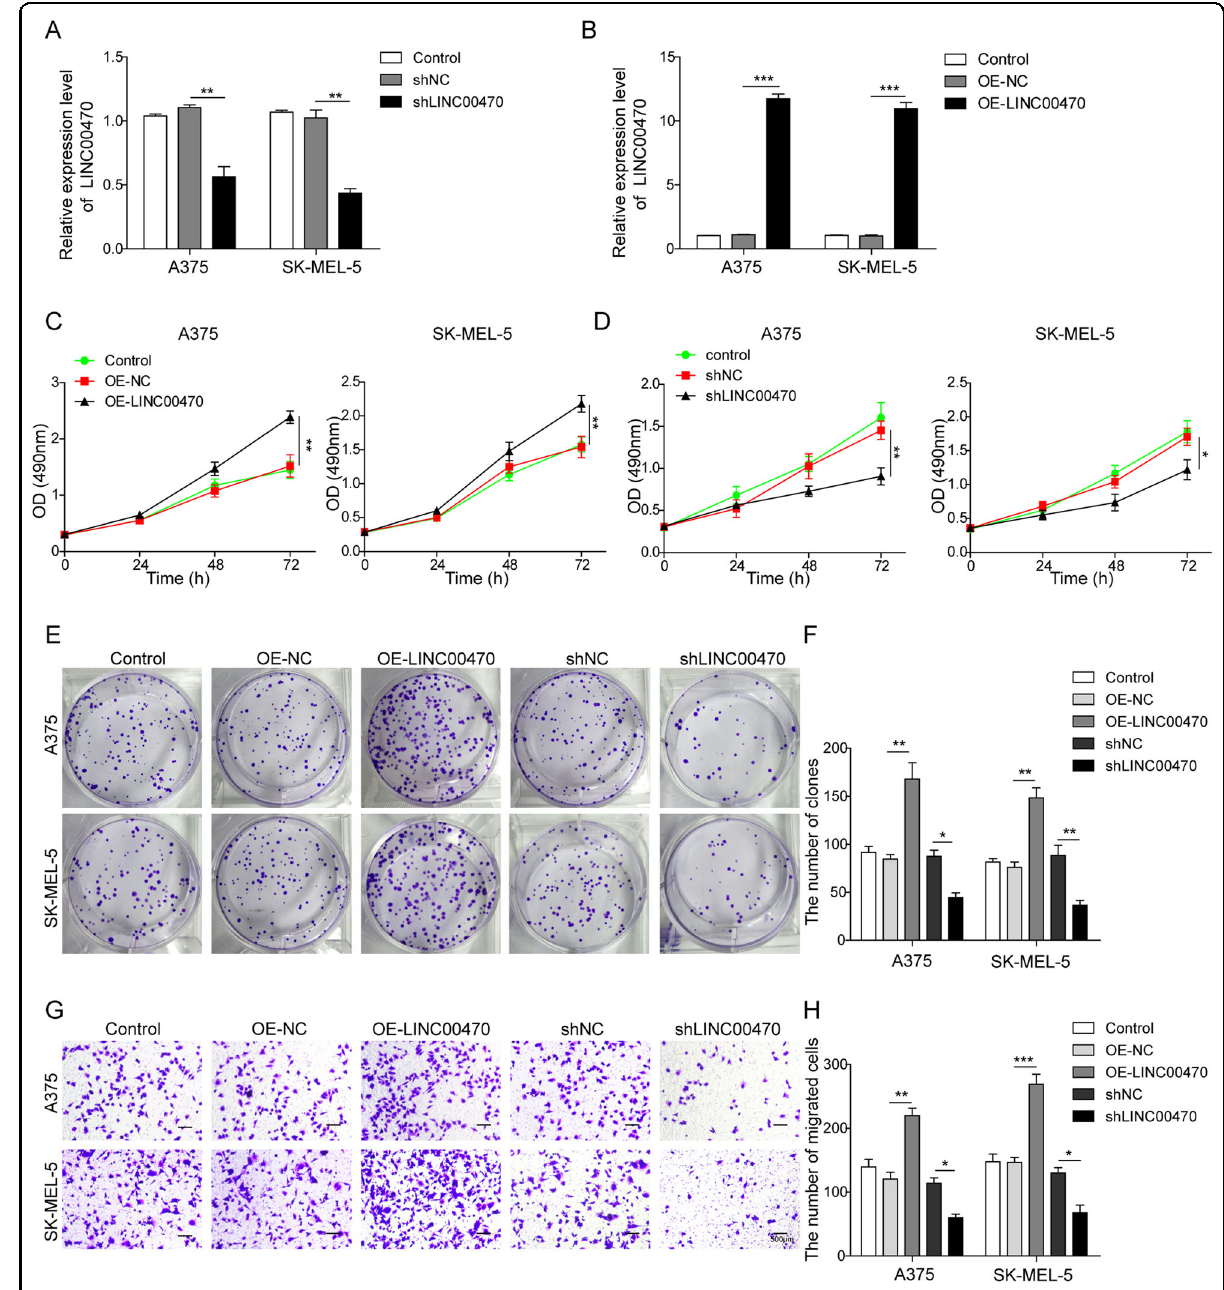
Fig. 3 LINC00470 facilitated the proliferation and migration of melanoma cells. A , B qRT-PCR analysis of LINC00470 of cells transfected with shNC, shLINC00470, OE-NC, and OE-LINC00470, respectively. C MTT assay of the cells after transfected with OE-NC and OE-LINC00470, respectively. D MTT assay of the after transfected with shNC and shLINC00470, respectively. E , F The colony formation assay of the cells after transfected with control, OE-NC, OE-LINC00470, sh-NC, and shLINC00470. G , H Migration ability of the cells after transfected with control, OE-NC, OE-LINC00470, sh-NC, and shLINC00470 evaluated by transwell assay. The mean ± SD in the graph shows the relative levels from three replicates. *p < 0.05, ** p <